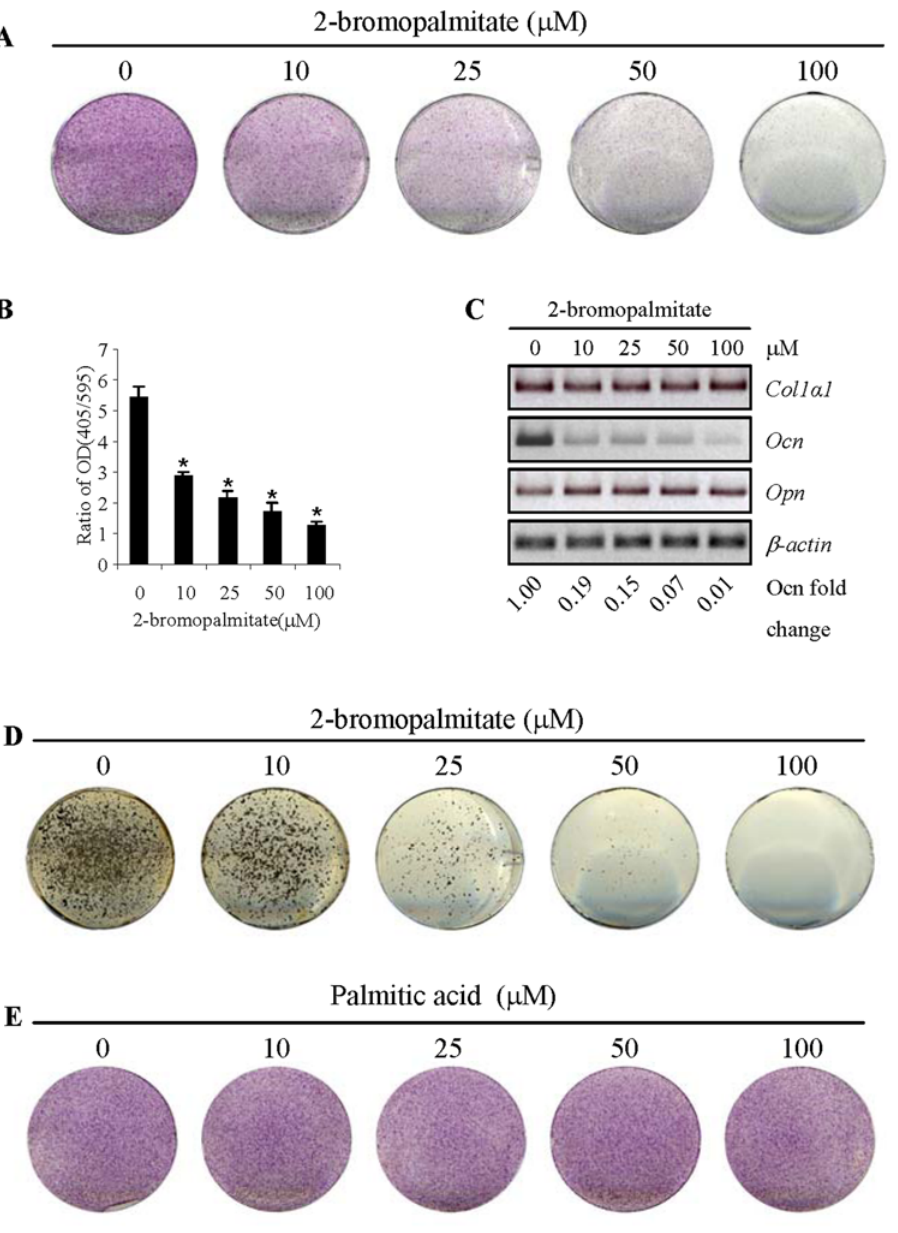
Figure 2. Inhibition of protein palmitoylation impeded osteoblast differentiation. A. The effect of 2BP on ALP staining. Primary osteoblasts were treated with increasing amounts of 2BP for 4 days in differentiation medium and then stained for ALP. B. Quantitation of ALP activities that were normalized to the protein levels of the cells. C. The effect of 2BP on the expression of several osteoblast differentiation markers. The experiments were carried out like Fig. 2A and total RNA were isolated from these cells. RT-PCR was carried out to determine the mRNA levels of these markers. The value of control (lane 1) was set at 1.00. D. The effect of 2BP on bone nodule formation. The experiments were carried out like Fig. 2A. After 21 days in culture, the plates were stained using a Von Kossa method.